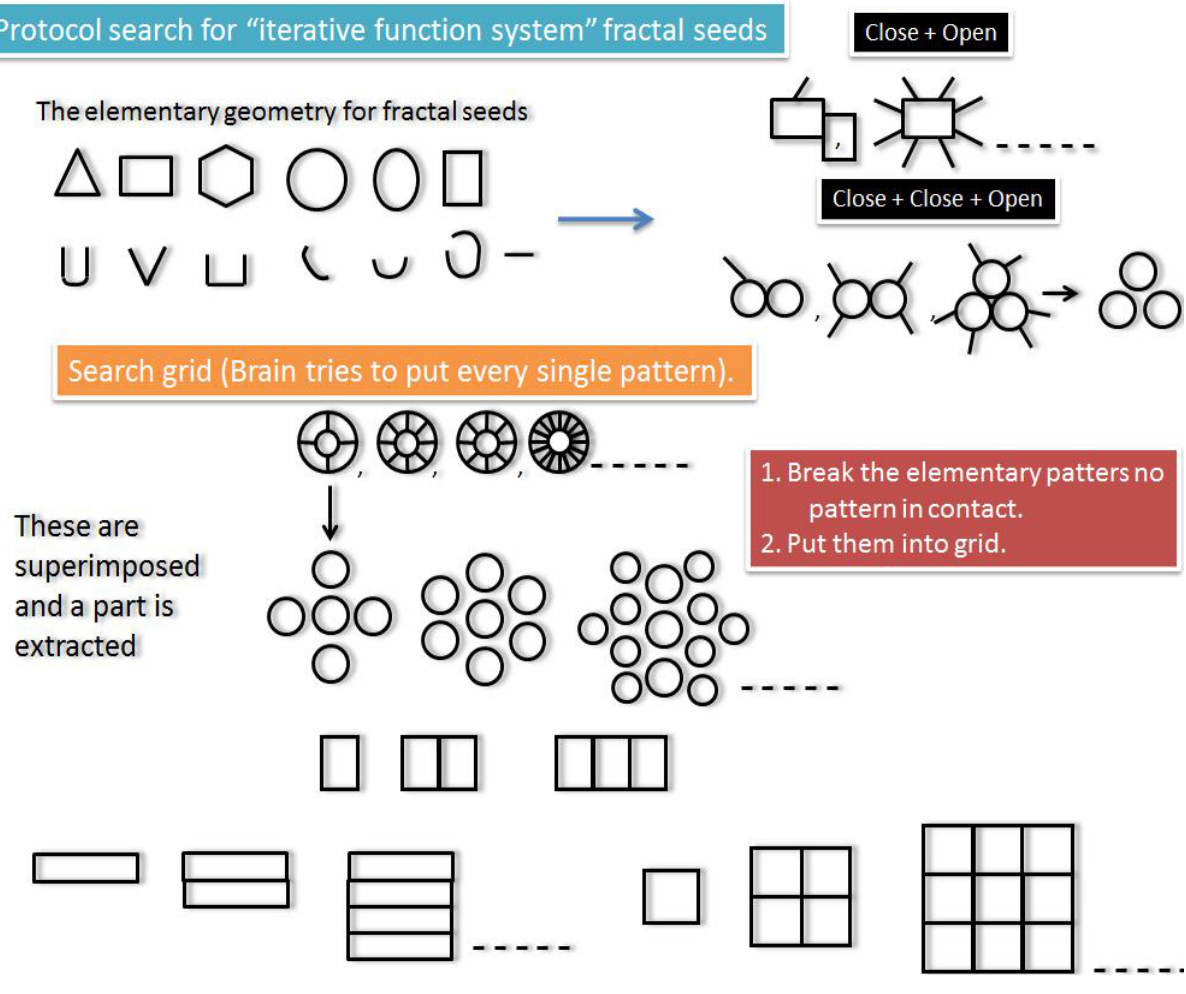
Figure 21. A diagram how an image is decomposed in terms of fractal